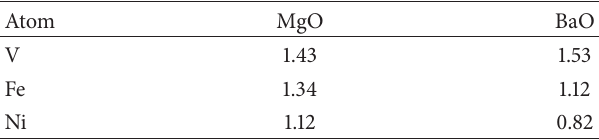
is above 3.2 ˚A which indicates that there is no interaction between them.